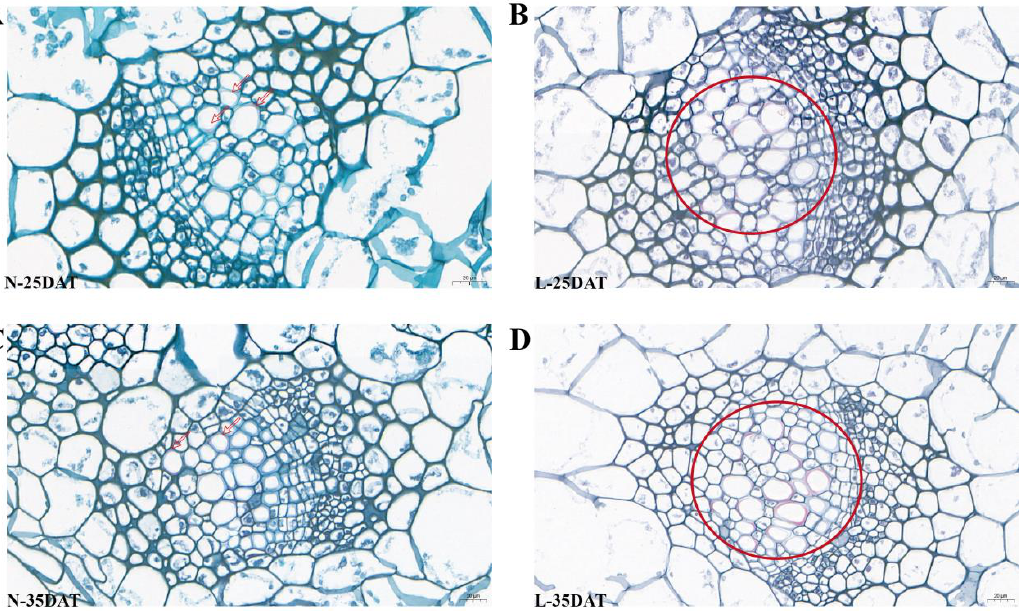
Figure 5. Safranin staining of lignin in ‘XBJ’ leaves at four treatments. ( A ) N-25DAT of ‘XBJ’ × 40; ( B ) L-25DAT of ‘XBJ’ × 40; ( C ) N-35DAT of ‘XBJ’ × 40; ( D ) L-35DAT of ‘XBJ’ × 40.